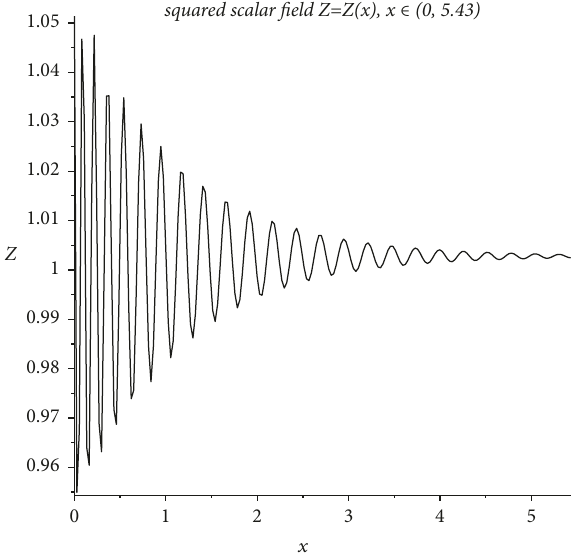
Figure 1: Relation of 𝑍 = 𝑌/𝑌 0 , 𝑍(1) = 1.0041022218 ; 𝑥 = 𝑡/𝑡 𝑚 is current age of the Universe.